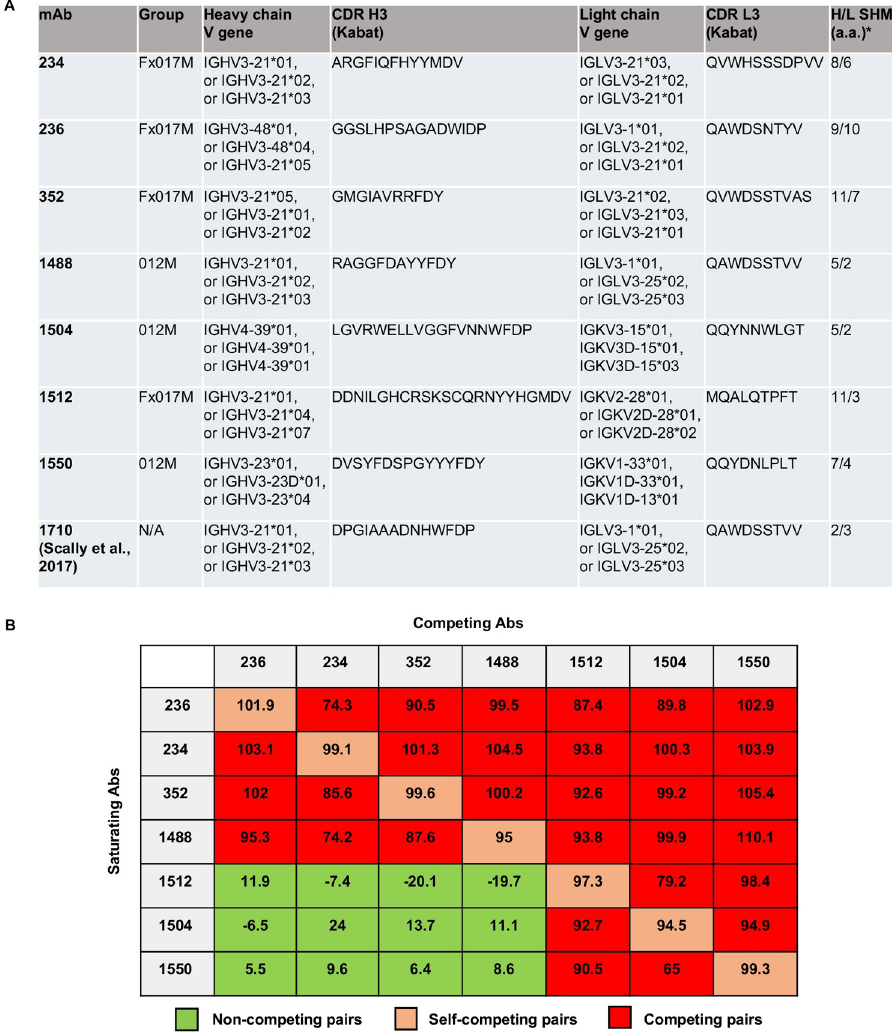
Fig 1. In vitro binning of ctCSP specific mAbs against recombinant CSP. ( A ) Immunogenetics ctCSP-specific mAbs. mAbs were isolated in a previous study (36) from donors undergoing both standard vaccination (months 0, 1, 2; 012M) and delayed fractional dosing (full dose at months 0, 1 + 1/5 dose at month 7; Fx017M). All mAbs were isolated from unique donors, except mAbs 234 + 236, and 1504 + 1550 were each derived from the same individual. The germline genes were identified using IgBLAST (NIH) with the three top hits reported, and the heavy/light chain somatic hypermutations (H/L SHM) of amino acid residues were derived from the comparison with the first top-hit gene. The complementarity-determining regions (CDRs) were defined based on the Kabat system. ( B ) Binning experiments were performed using bio-layer interferometry on an Octet HTX at 25˚C. An in-tandem binning assay format was set up. Biotinylated Pf CSP was loaded onto streptavidin sensors. Loaded sensors were dipped into saturating Ab followed by competing Ab. Values are displayed as percent inhibition of binding to Pf CSP (see Materials and Methods). Pairs with greater than 50% inhibition were considered competing